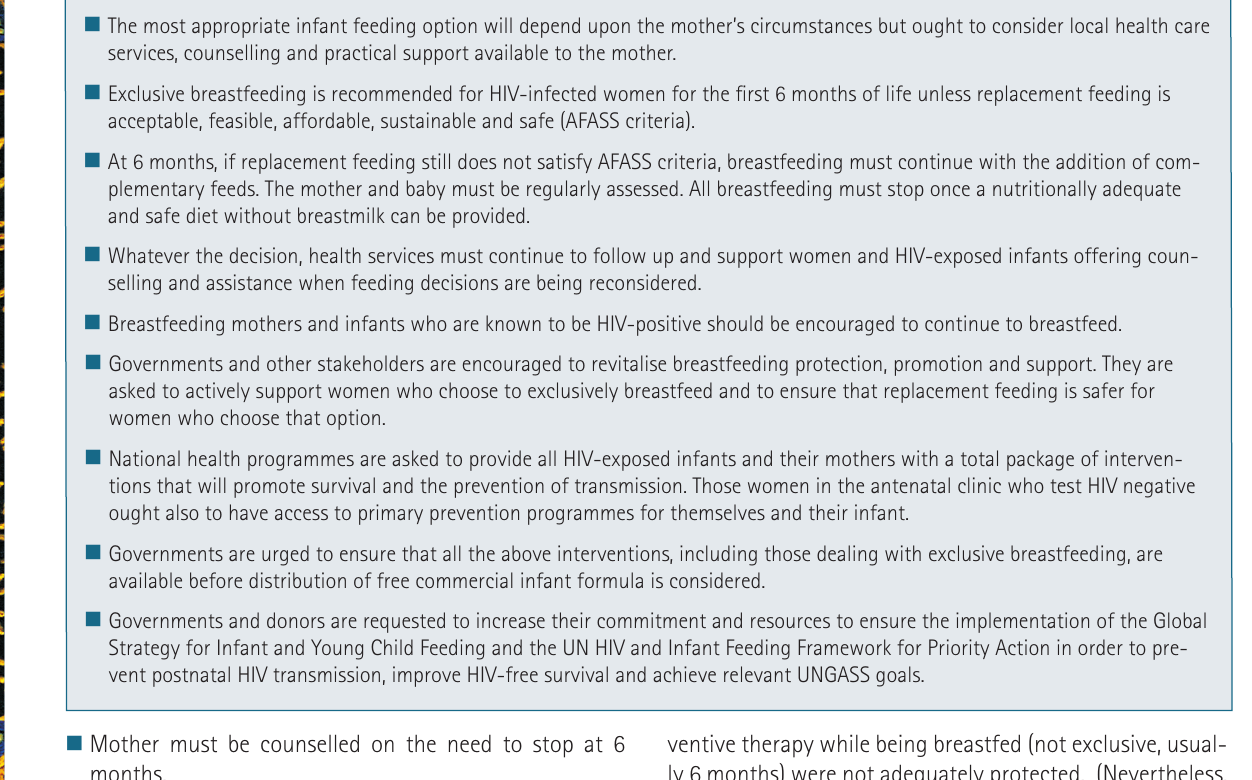
TABle 4.III. WORlD HeAlTH ORGANIzATION 2006 BReAsTFeeDING ReCOMMeNDATIONs